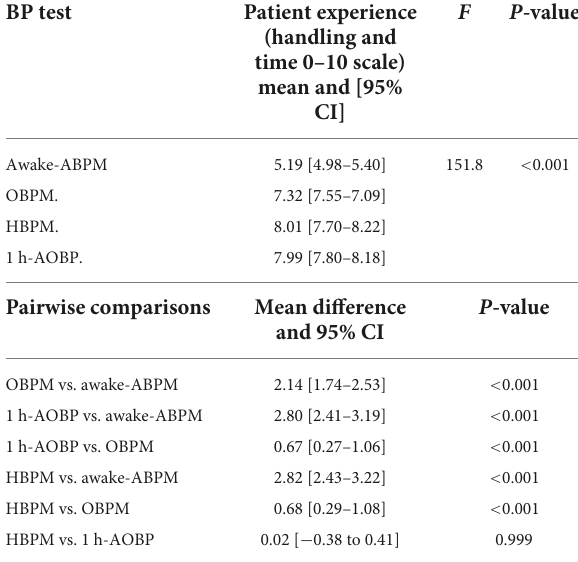
TABLE 3 ANOVA test and pairwise comparisons (Tukey HSD tests) to examine the patient experience of each BT method. BP test